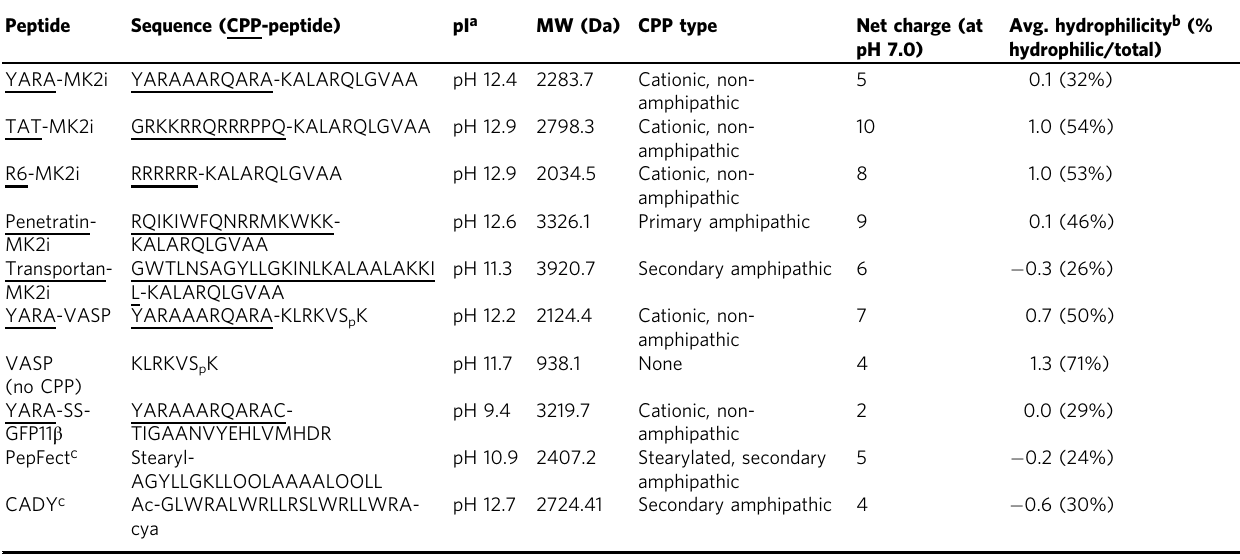
Table 1 Characteristics of cell penetrating peptides utilized